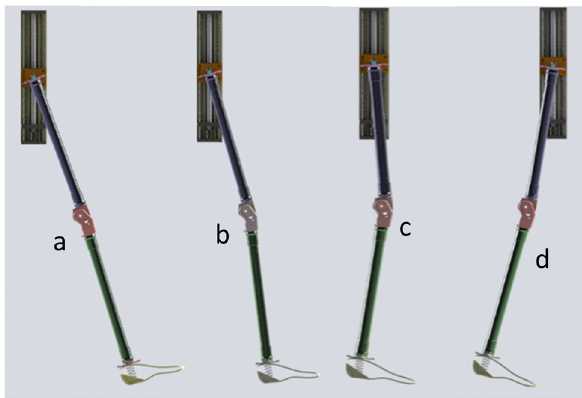
Figure 21: The stance phase of gait cycle: ( a ) initial contact; ( b ) loading response; ( c ) mid - stance; and ( d ) terminal.